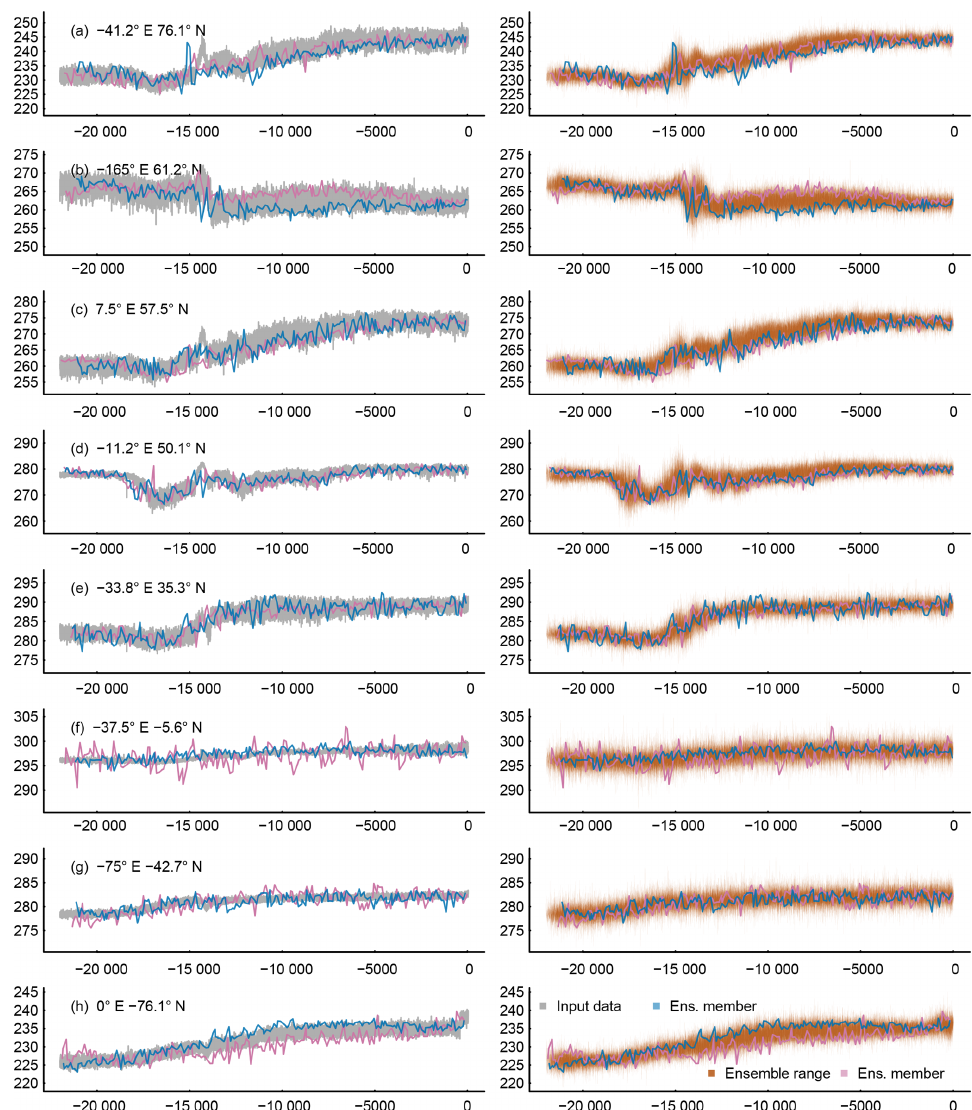
Figure 11. Visualizing the surrogate proxy ensemble at selected locations (longitude and latitude in top left corners of the left column panels). The left column shows the input data plotted as grey lines, and two random members of the ensemble as blue and purple lines. The right column plots the range of the ensemble transparently shaded brown, and blue and purple lines are the same two random members. The x axes are years BP. The panel on the bottom right shows the figure